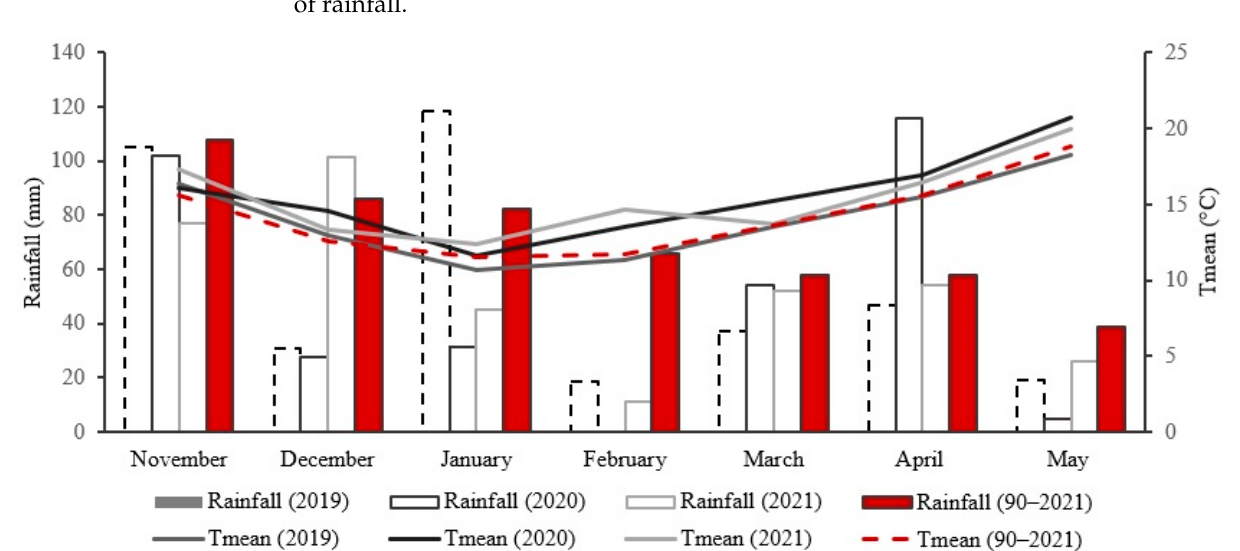
Figure 1. Monthly rainfall and mean air temperatures at the experimental site during the three growing seasons (2019, 2020, and 2021) compared to the year historical means